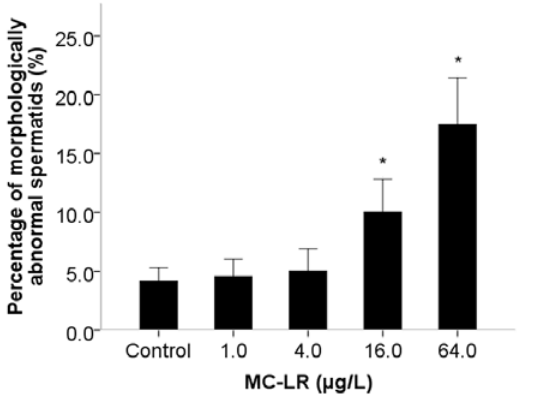
Figure 2. Effects of MC-LR exposure on spermatids morphology. Bars represent means ± SEM. * p < 0.05 vs . the control group.